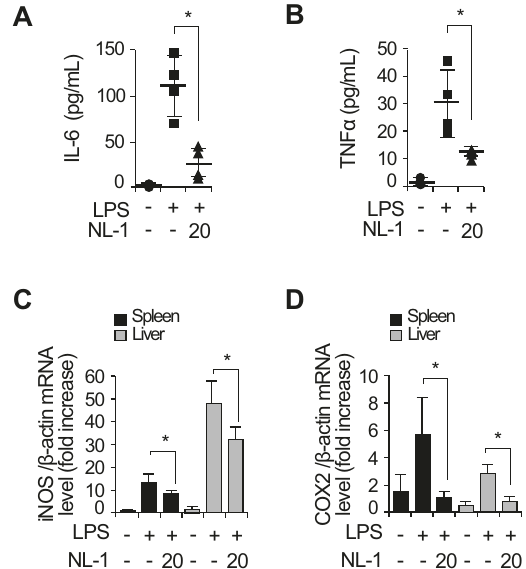
Fig. 4 Expression of in fl ammatory mediators triggered by LPS- induced sepsis was diminished in the presence of a mitoNEET inhibitor. C57BL/6 mice were injected intraperitoneally with vehicle, LPS (20 mg/kg), or LPS plus NL-1 (20 mg/kg). Blood was collected from the right atrium 48 h later, and IL-6 and TNF α levels in serum were measured ( A and B ). Total RNA was harvested from the spleen and liver. Expression of mRNA encoding iNOS and COX2 was assessed in the spleen or liver ( C and D ) by quantitative real-time RT- PCR. For all real-time PCR analyses, β -actin was used as a control for normalization. All data are expressed as the mean ± SD from three independent experiments. *P < 0.05 for LPS vs. LPS plus NL-1